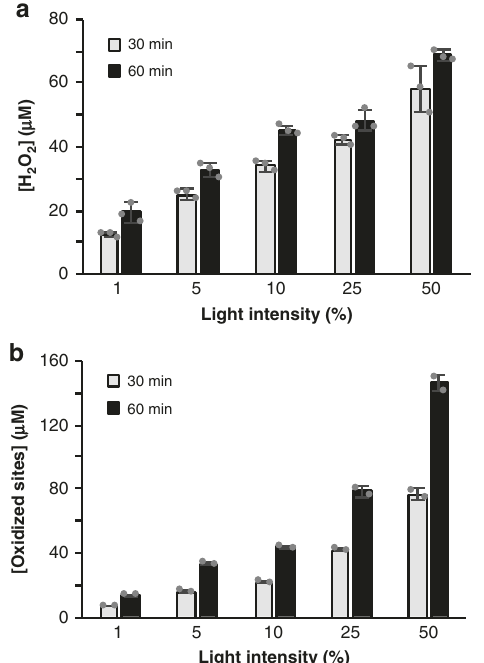
Fig. 3 The effect of light intensity on H 2 O 2 production and LPMO activity in the Chl-system. The graphs show, for different light intensities (100% = approx. 168 W cm − 2 ), a the apparent quantity of H 2 O 2 generated in reactions with Chl (500 µ M)/light and Avicel and b the amount of soluble aldonic acid products released in identical reactions that also contained Sc AA10C (0.5 µ M). See Supplementary Fig. 3b – d for complete time courses of Sc AA10C-catalyzed oxidation of Avicel. Note that direct quantitative comparison of the levels of produced H 2 O 2 and oxidized products is not possible because only soluble LPMO products were quanti fi ed, and, more importantly, measured H 2 O 2 levels re fl ect the net result of H 2 O 2 production and H 2 O 2 – consuming side reactions, as discussed in the main text. All reactions were carried out in sodium phosphate buffer (50 mM, pH 7.0) at 40 °C, under magnetic stirring and contained 10 g L − 1 Avicel. Before product quanti fi cation, solubilized cello-oligosaccharides were hydrolyzed by Tf Cel5A, to convert the LPMO products to a mixture of only two oxidized products with a degree of polymerization of 2 and 3 [GlcGlc1A, (Glc) 2 Glc1A], the amounts of which were summed up to yield the concentration of oxidized sites. Error bars show ± s.d. ( n = 3 for a and n = 2 for b , independent experiments). Source data are provided as a Source Data